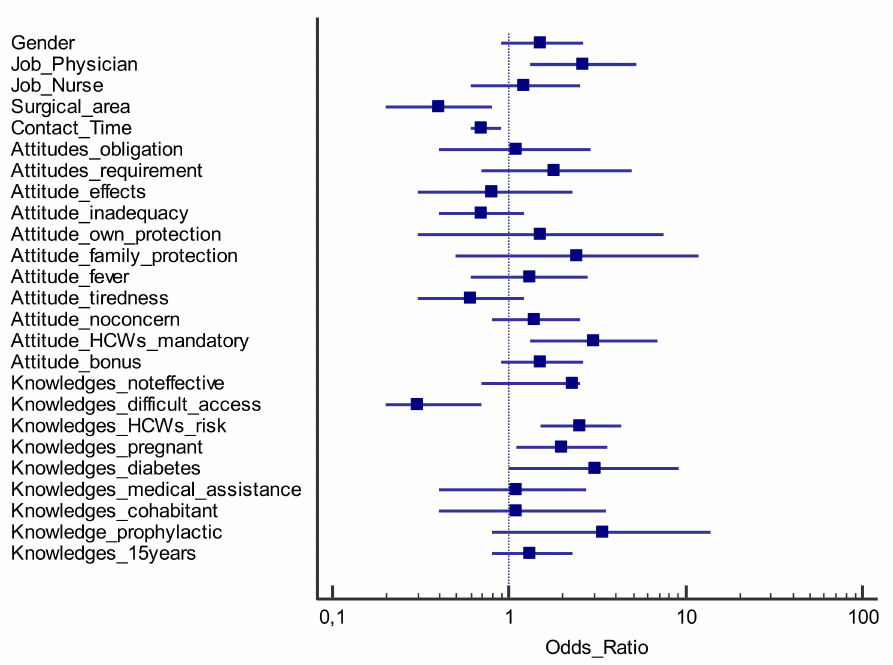
Figure 1. Forest plot reporting the multivariate logistic analysis results; odds ratios and 95% confidence intervals (question_answer) concerning the observed outcome (vaccinated / unvaccinated subjects in the 2018–2019